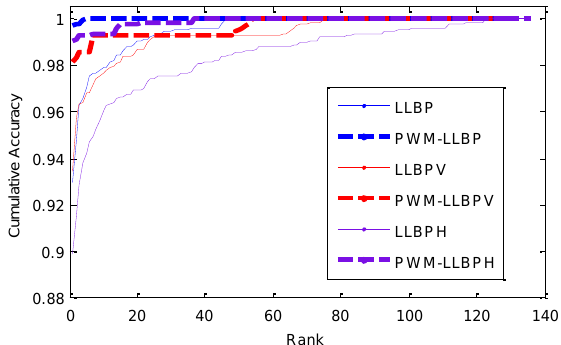
Figure 14. Cumulative match curves by different